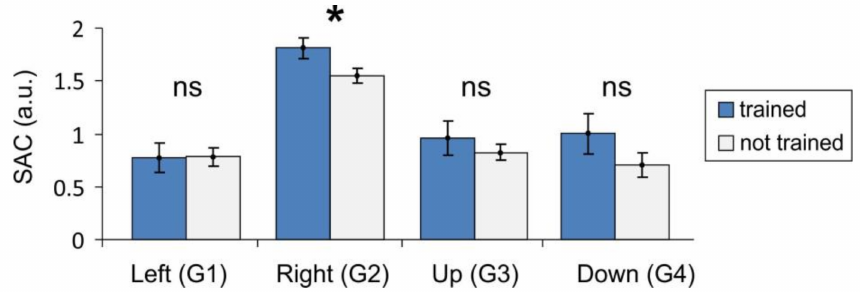
Figure 4. Synergist–antagonist coefficient (SAC) for trained and not trained subjects (mean values and standard errors are shown; star marks statistically significant